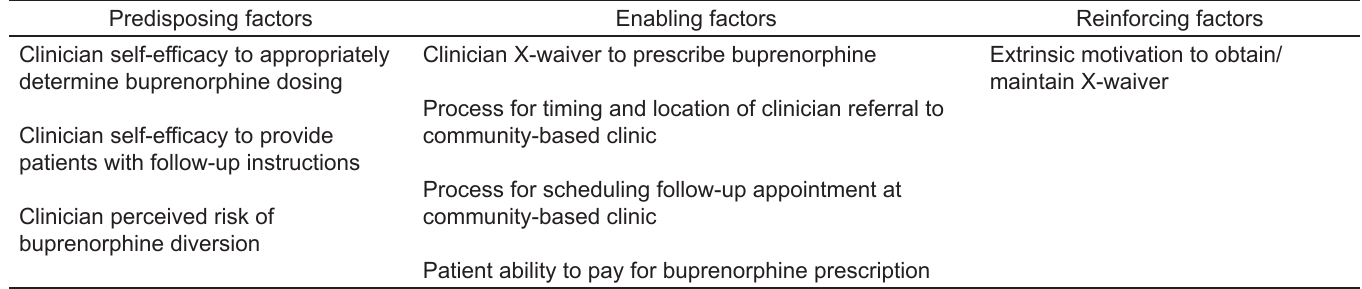
Table 1. Predisposing, enabling, and reinforcing factors for emergency clinicians to prescribe buprenorphine and refer patients to follow-up